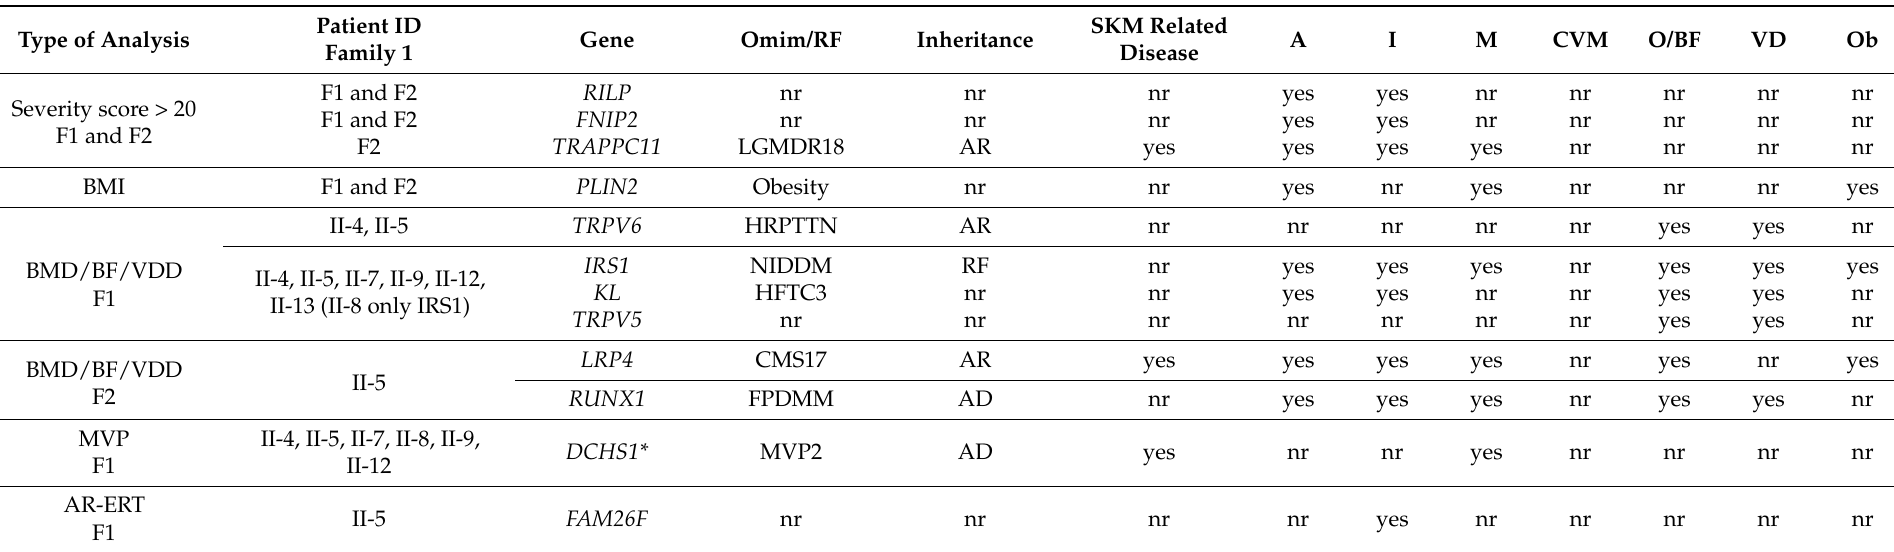
Table 4. Genes selected by functional prioritization in families 1 and